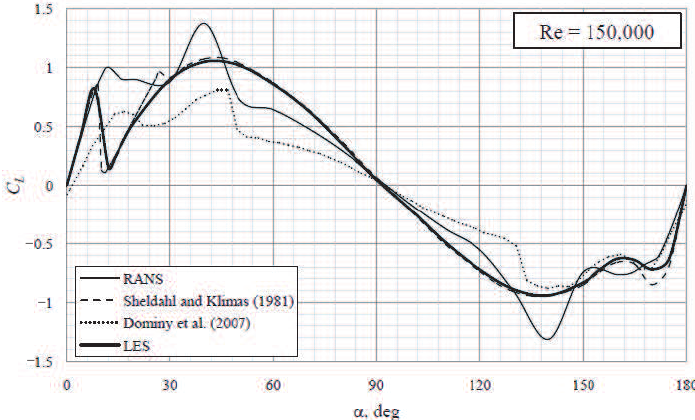
Figure 19. Lift as a function of AOA at Re = 1.5 × 10 5 .